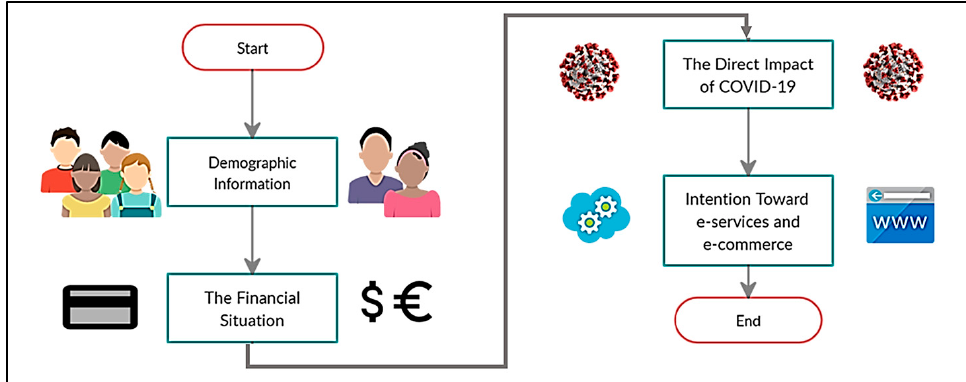
Figure 1. The Sections of the Conducted Survey.